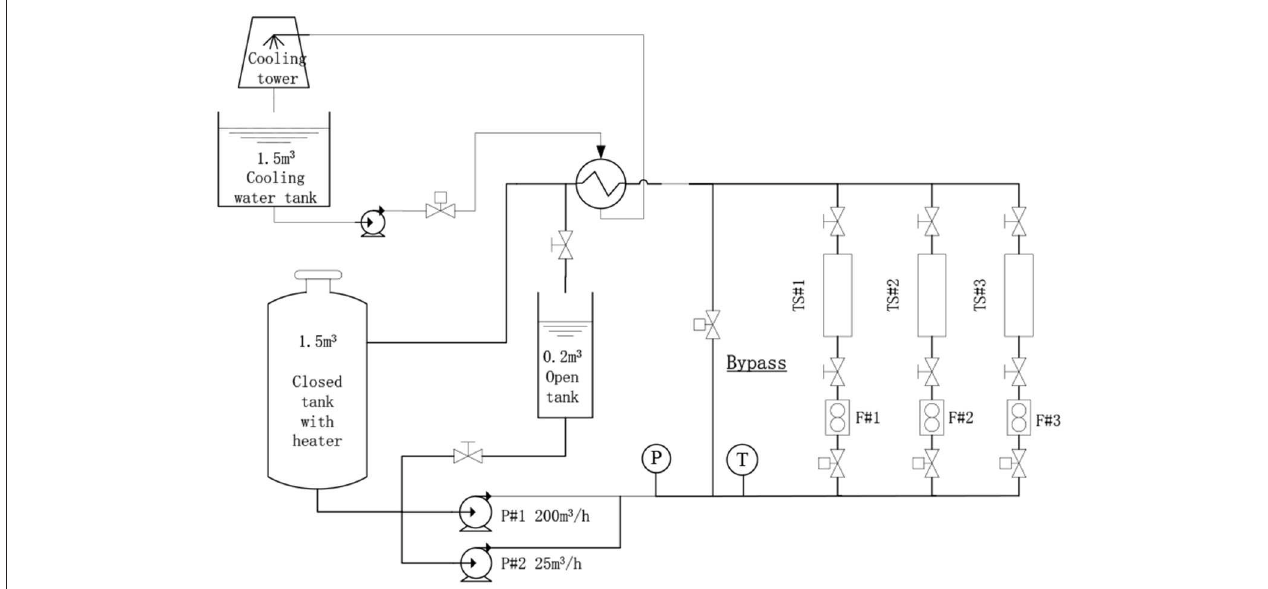
FIGURE 1 | Schematic of test facility utilized in the experiment (Xiong et al.,